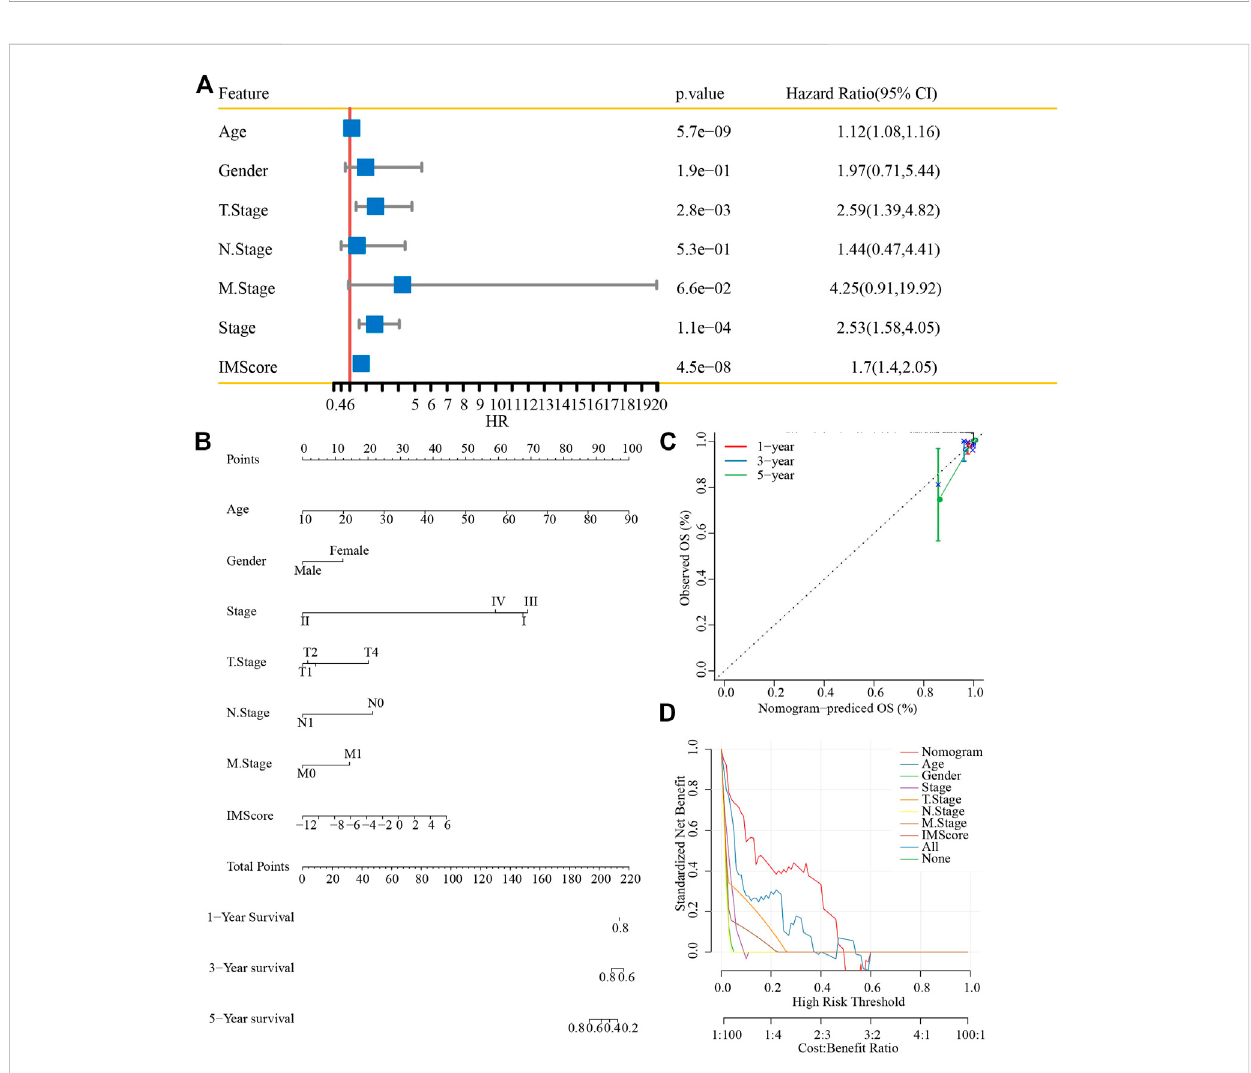
FIGURE 10 Nomogram construction. (A) Univariate analysis of the IMScore and clinical features. (B) Nomogram that incorporated the IMScore and clinical features was developed. (C) Calibration curve. (D) Decision curve